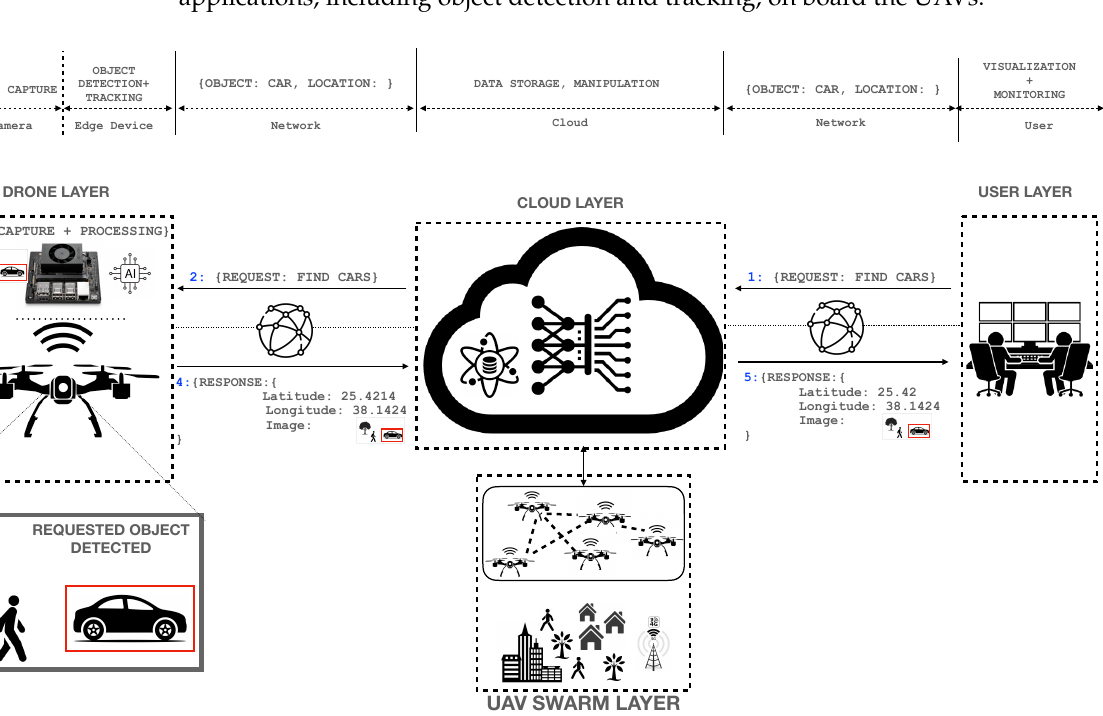
Figure 1. AERO system